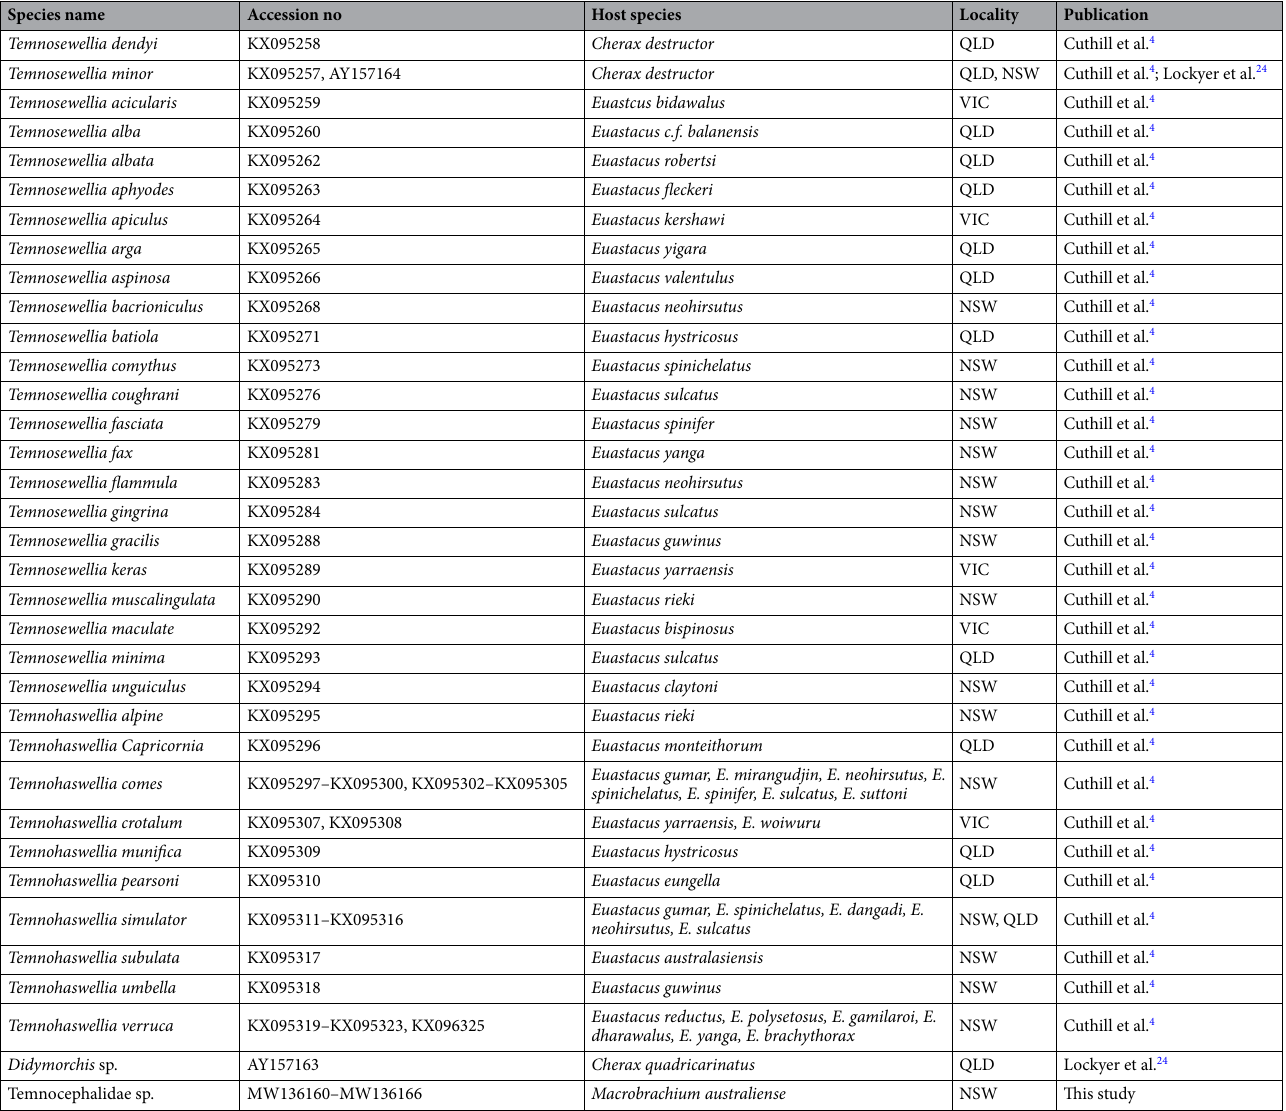
Table 1. Details of sequences used to build phylogenetic tree in the present